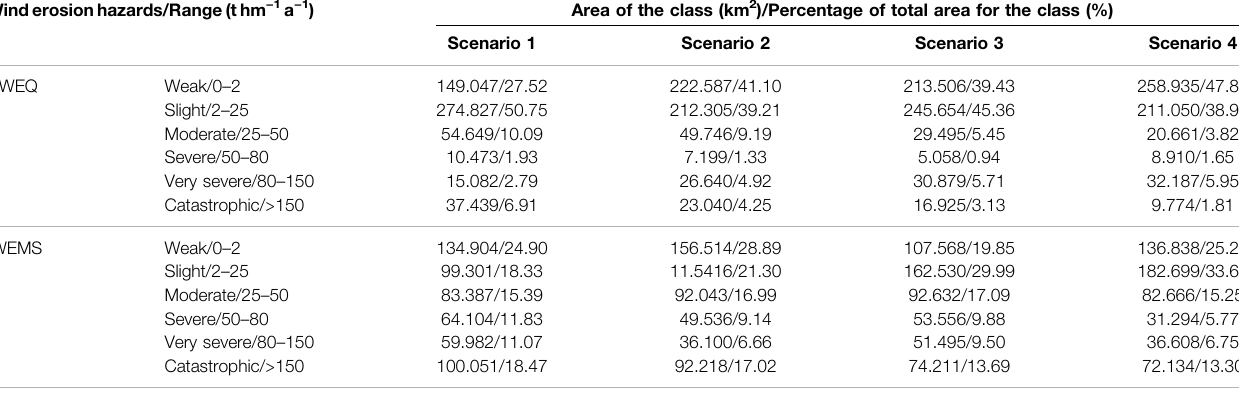
TABLE 6 | The area and percentage of the wind erosion hazards determined using the RWEQ and IWEMS for different scenarios. Winderosionhazards/Range(thm − 1 a − 1 ) Area of the class (km 2 )/Percentage of total area for the class (%)